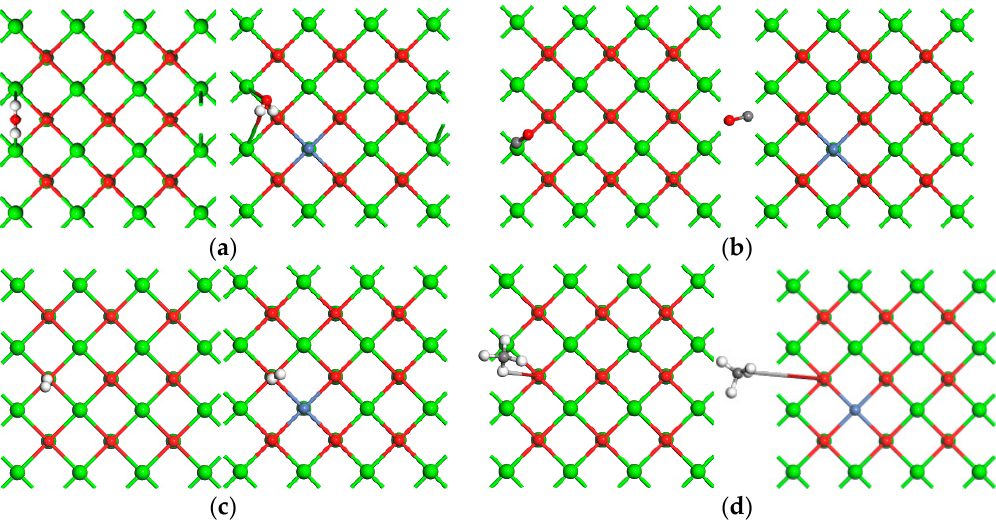
Figure 4. The adsorption configurations of gas molecules on CaO-based surfaces at 650 °C, left and right represent CaO and Ni/CaO: ( a ) the adsorption configuration of H 2 O; ( b ) the adsorption configuration of CO; ( c ) the adsorption configuration of H 2 ; ( d ) the adsorption configuration of CH 4. Green, red, gray, white, and purple balls represent Ca, O, C, H, and Ni atoms.